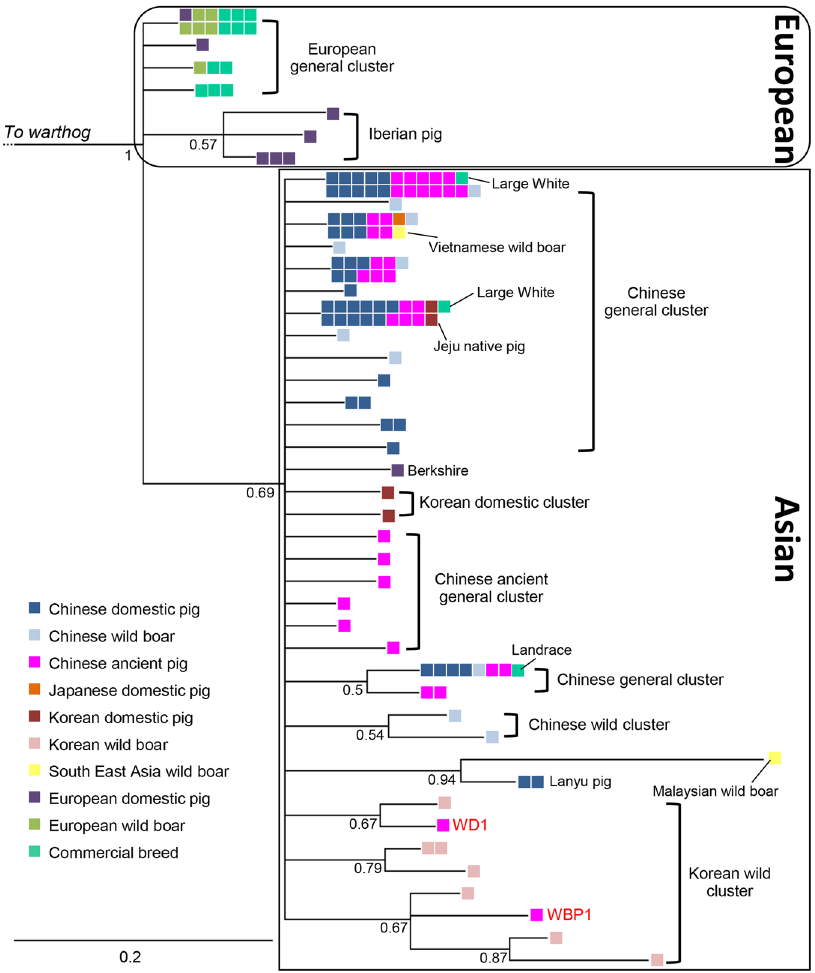
Figure 2. Bayesian consensus phylogenetic tree of the 37 combined ( Cytb and control region) ancient pig sequences and 98 extant published homologous sequences. Ages (modern vs. ancient), status (wild vs. domestic) and geographical origin are depicted in different colours (see bottom left of the figure). The European and Asian sequence clusters are